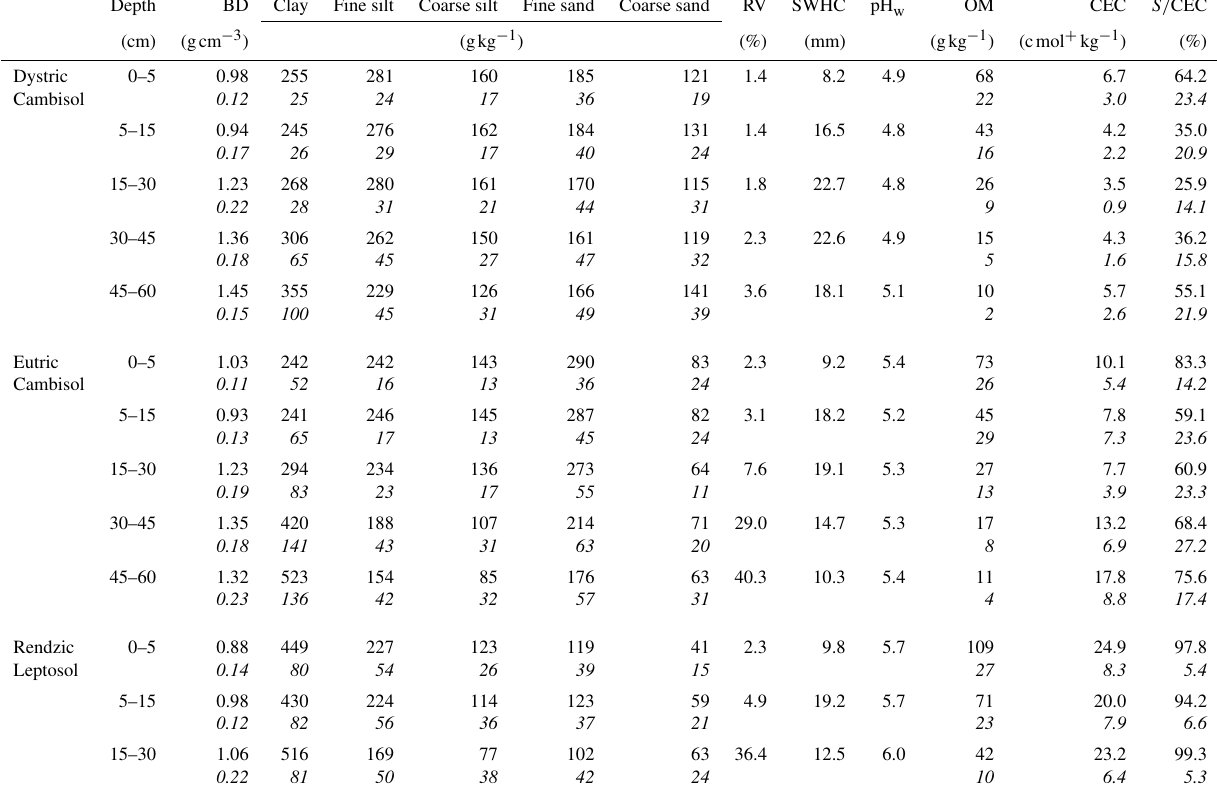
Table 1. Physicochemical properties of the three studied soils at the Montiers site (plot DC, plot EC, plot RL). Presented are the mean values for bulk density (BD), textural distribution (clay, fine silt, coarse silt, fine sand and coarse sand), total rock volume (RV), soil water holding capacity (SWHC), soil water pH (pH w ), organic matter content (OM), cation exchange capacity (CEC; cmol + kg − 1 ) and base-cation saturation ratio ( S/ CEC, with S as the sum of base cations). SD values are given in italics. Table adapted from Kirchen et al.